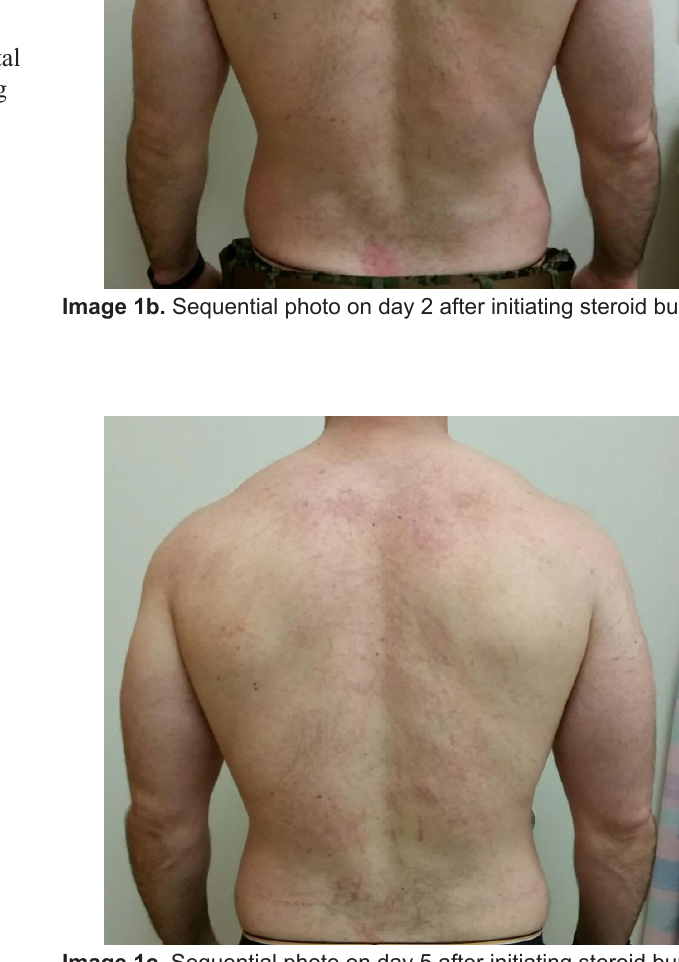
Image 1c. Sequential photo on day 5 after initiating steroid